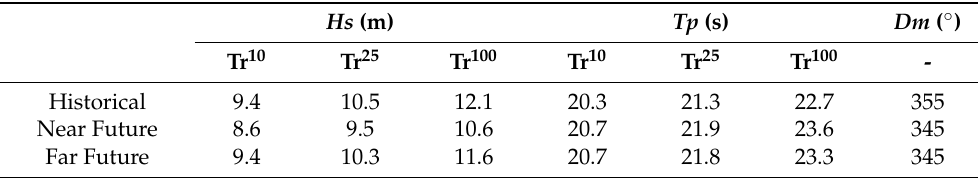
Table 6. Wave height ( Hs ), peak period ( Tp ), and mean wave direction ( Dm ) for each climate period and return